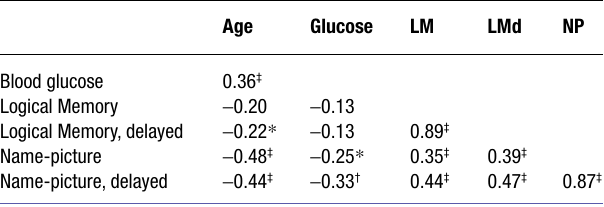
Table 1 | Memory, age, and fasting blood glucose: zero-order correlations.